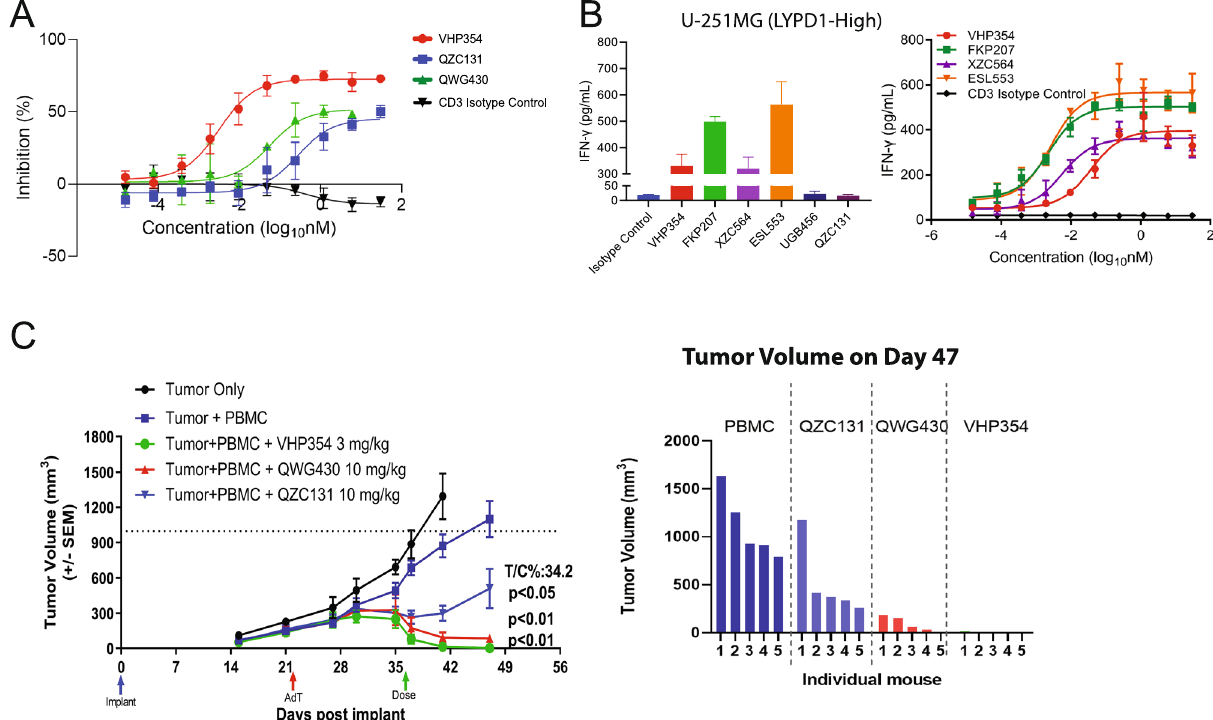
cells U251 demonstrate selective and dose-dependent induction of T cell-mediated cytotoxicity for VHP354 (red), QWG430 (green) and QZC131 (blue). 10-point dose response curves from a starting concentration of 100 nM of VHP354 (red), QWG430 (green) or QZC131 (blue) demonstrate differential activity across time-points. ( B ) Cytokine release assays by MSD demonstrate dose-dependent IFN-γ production in the high LYPD1-expressing cell line U251 following 48 h treatment with the LYPD1-directed TCBs FKP207 (green), ESL553 (orange), VHP354 (red), XZC564 (purple), QZC131 (dark purple) and UGB456 (dark blue). ( C ) In